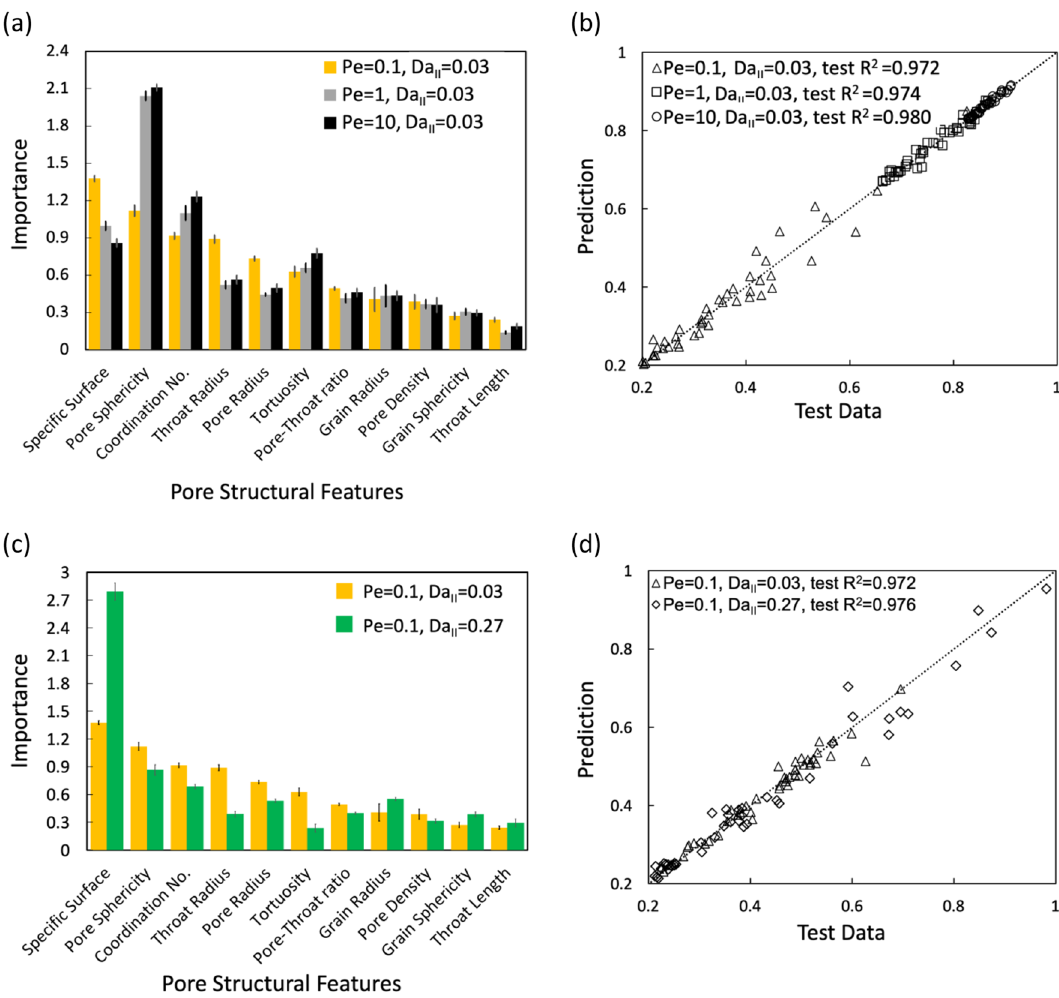
Figure 5. ( a ) Importance estimation of pore structural features at three different Pe (0.1, 1, and 10) with Da II = 0.03 (the corresponding Da values are 0.3, 0.03, 0.003) and ( b ) the corresponding prediction performance of ANN models using the three pore structural features from 300 instances; ( c ) importance estimation of pore structural features at Da II = 0.03 and 0.27 (the corresponding Da values are 0.3, 2.7) with Pe = 0.1 and ( d ) the corresponding prediction performance of ANN models using the three pore structural